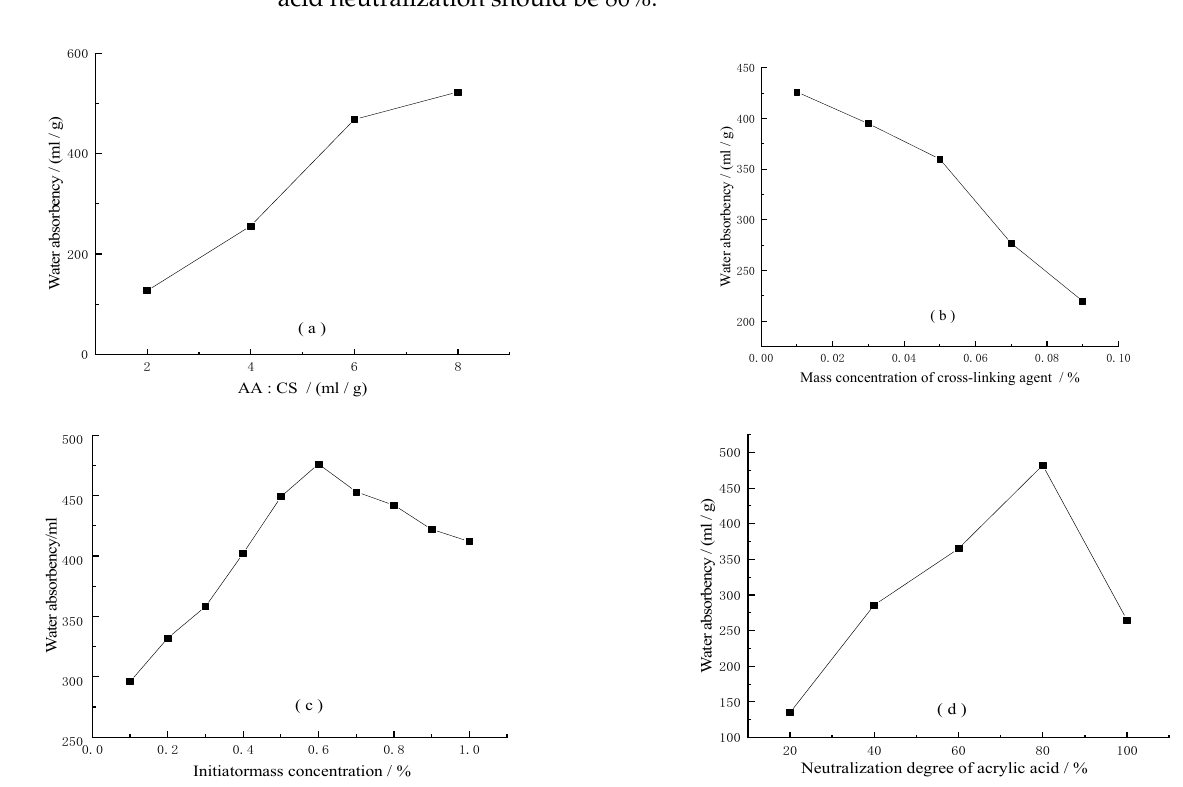
Figure 6. Trends in indicators versus factors, ( a ) chitosan and acrylic monomer ratios, ( b ) cross- linking agent dosage, ( c ) neutralization degree of acrylic acid, ( d ) neutralization degree of acrylic